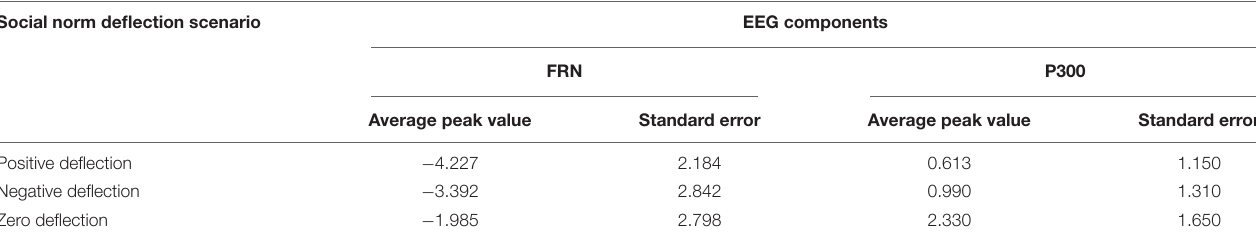
TABLE 1 | The average peak value and standard error of FRN and P300 in the social norm deviation scenario. Social norm deflection scenario EEG